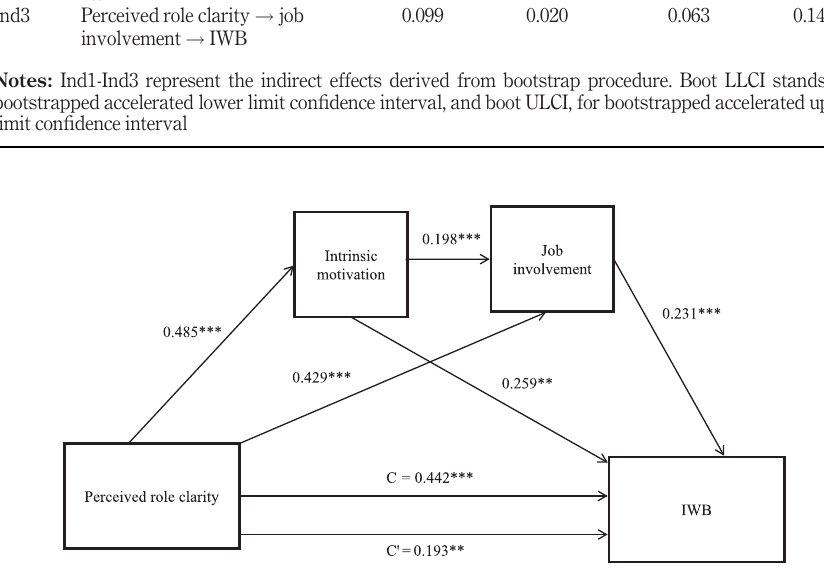
Figure 1. Estimated serial multiple mediation